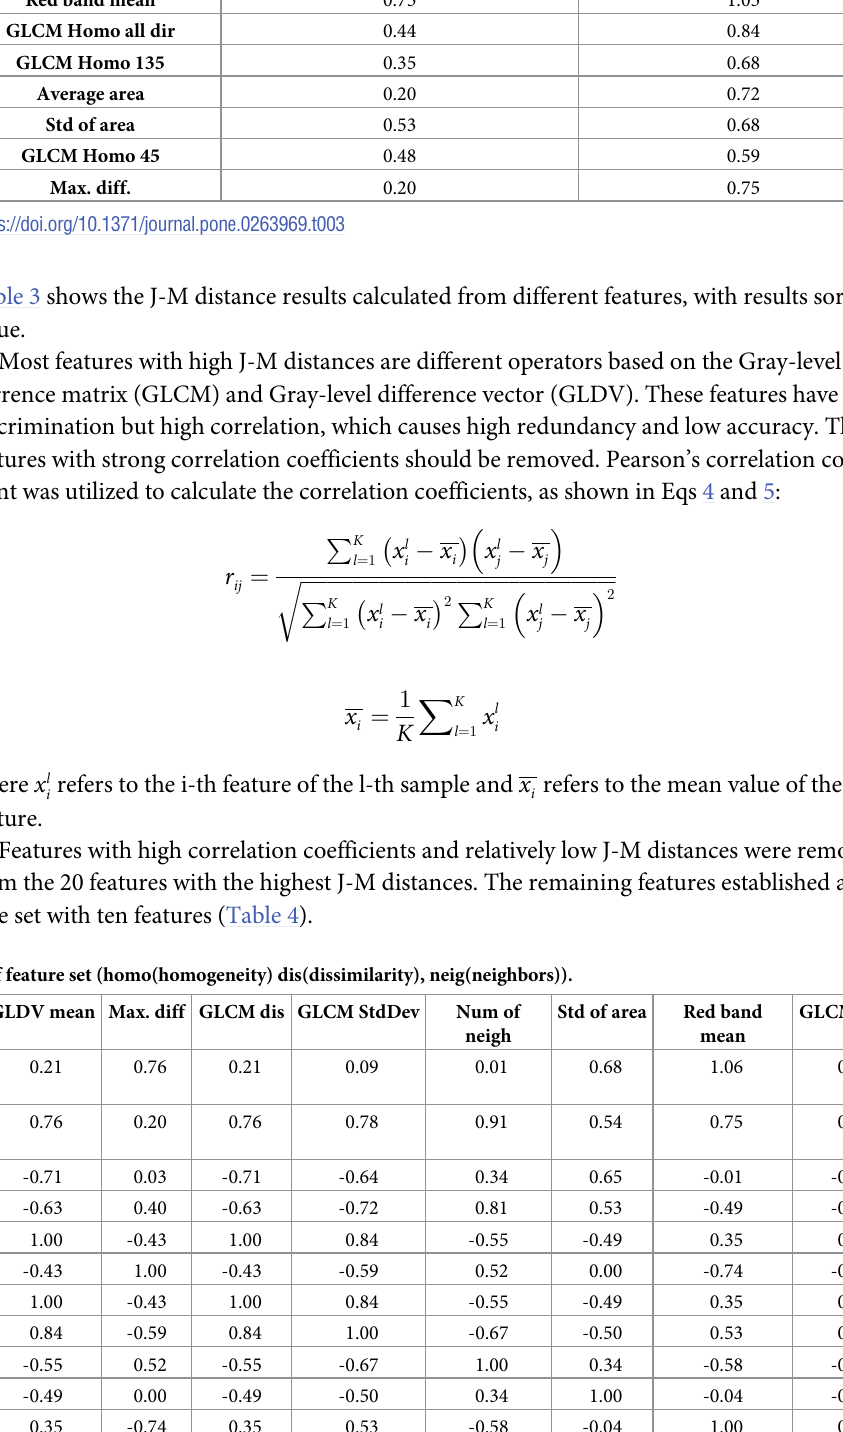
Table 3. J-M distances of part features (Homogeneity(Homo)). J-M distance (tea and corpland)